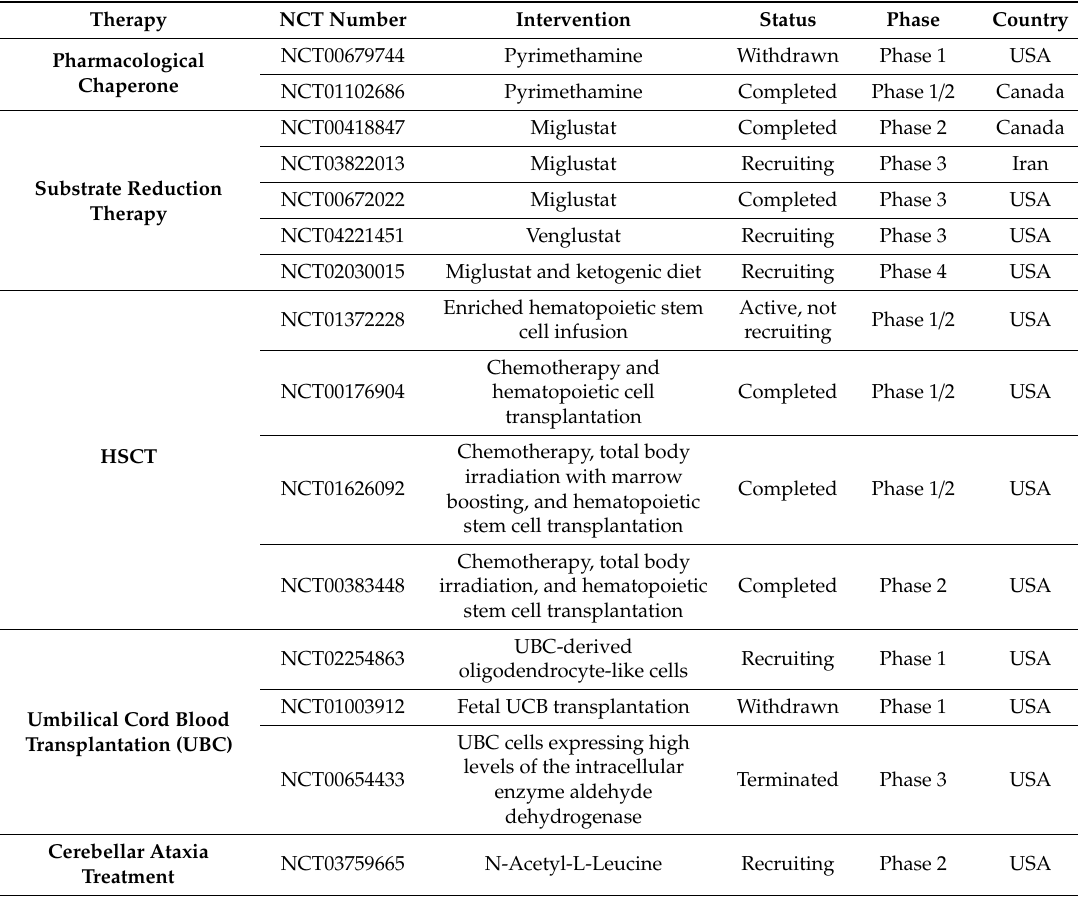
Table 2. Clinical trials for GM2 gangliosidoses reported at Clinicaltrials.gov by June